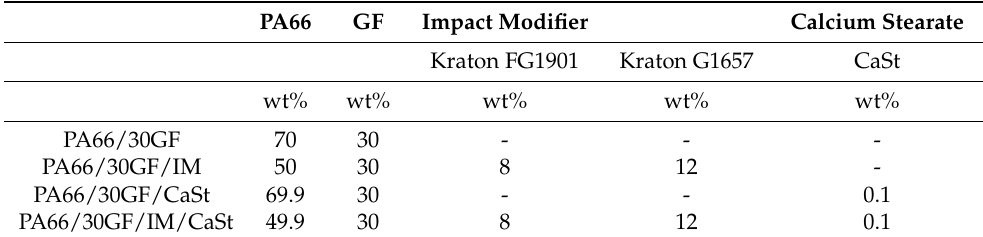
Table 1. Compositions of charges produced by